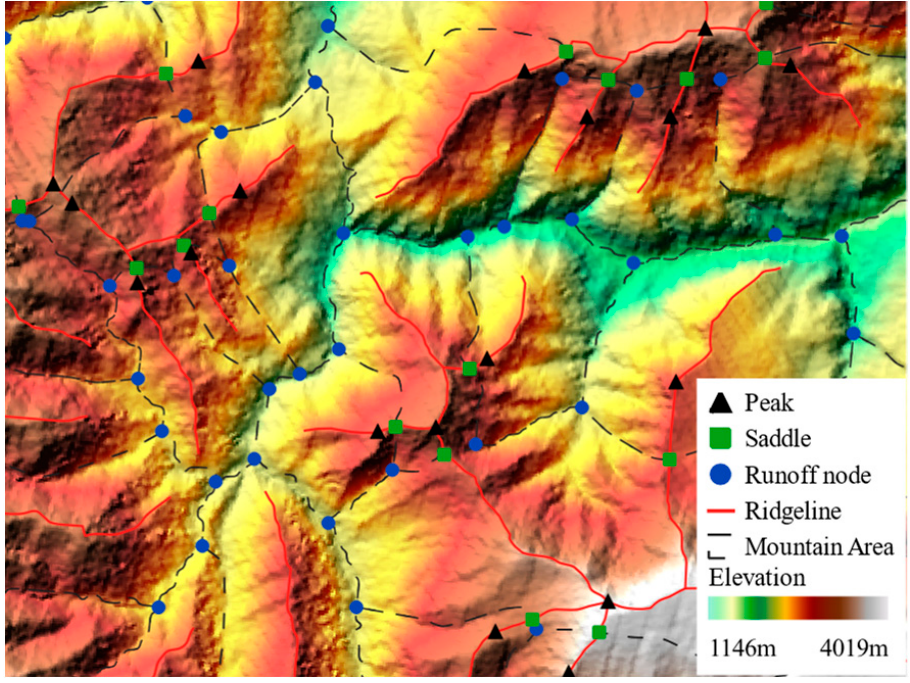
Figure 1. Principle of the integrated point cluster extraction: the black triangles, green squares and blue dots represent peaks, saddles and runoff nodes, respectively; the red lines represent ridgelines, and the black dashed boxes represent the mountain control areas.